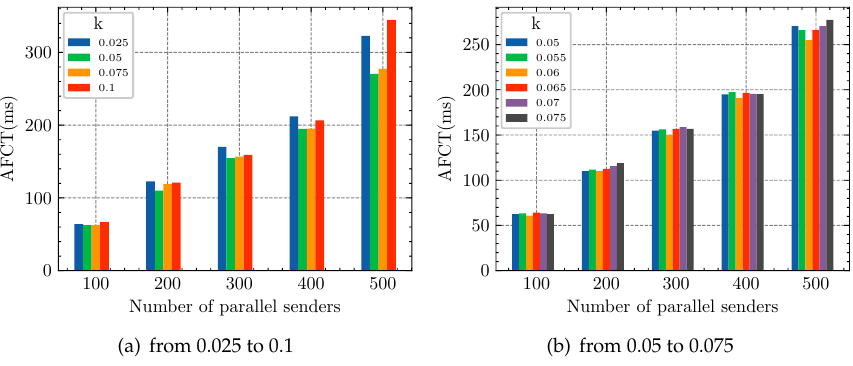
Figure 7. AFCT for short flows with different k